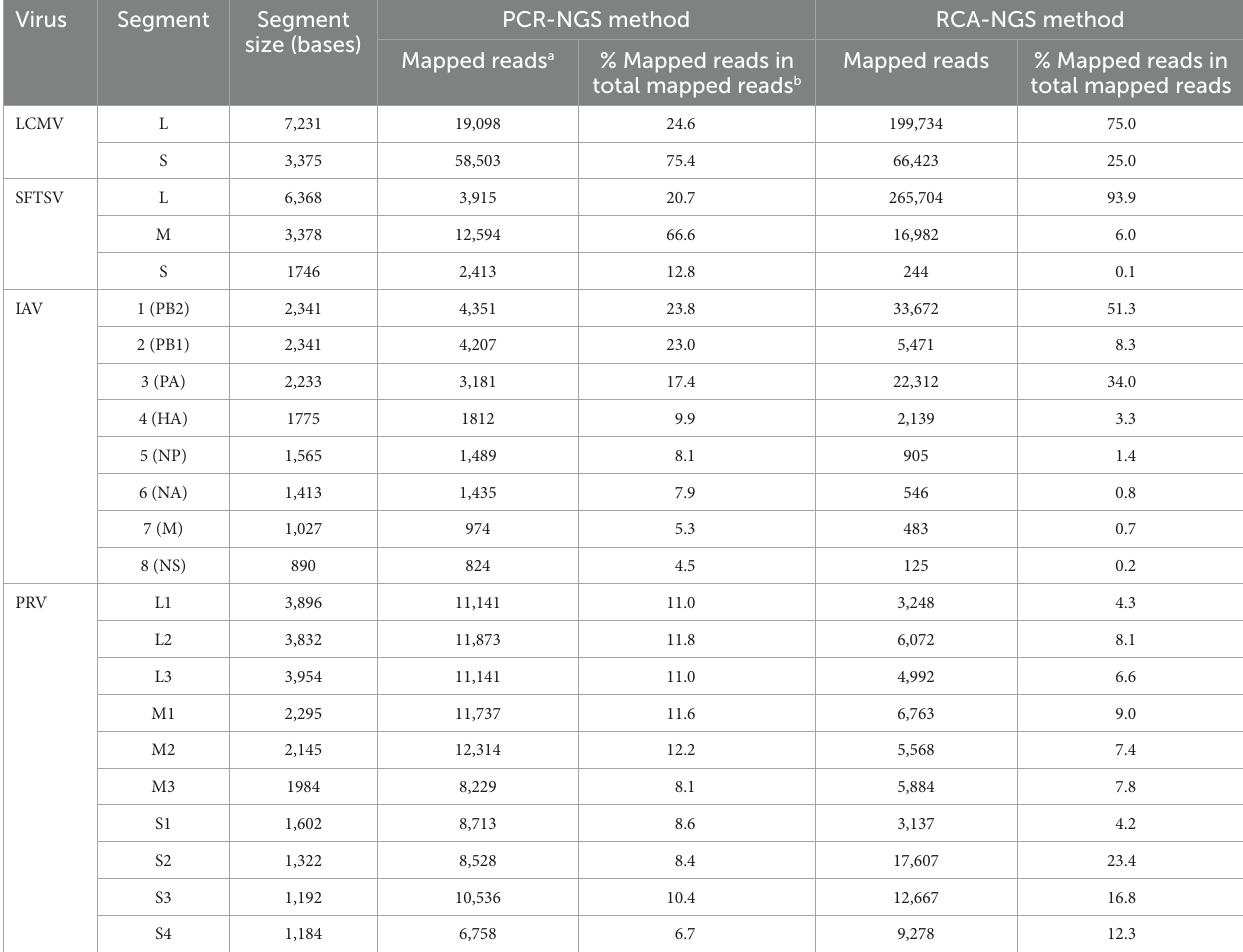
TABLE 4 Number and percentage of reads aligned to each